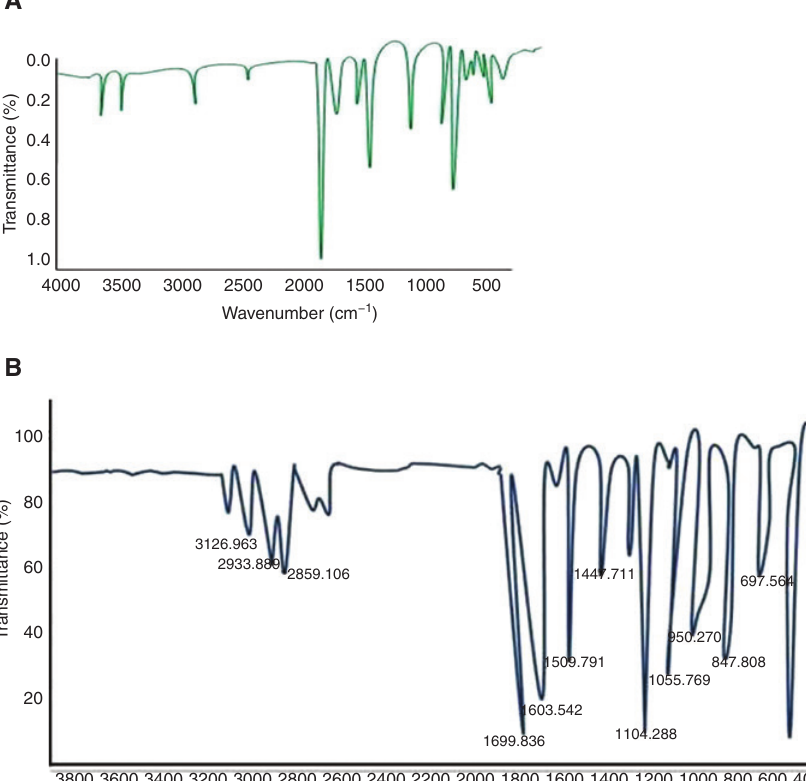
Figure 2: (A) The Fourier transforms spectra of nisoldipine. (B) The Fourier transforms spectra of nanoparticles.